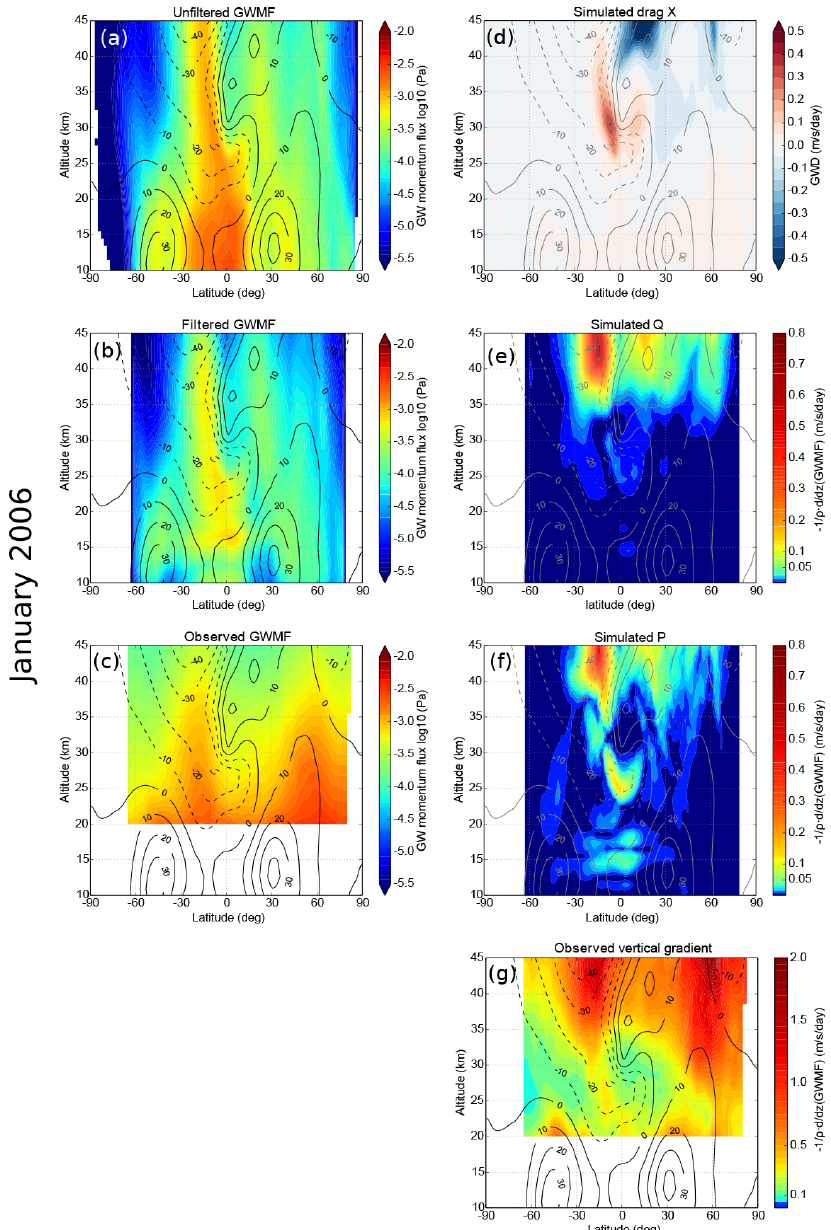
Figure 4. Comparison of simulated GWMF and its vertical gradients with observations from HIRDLS for January 2006. Panel (a) shows simulated unfiltered absolute GWMF. Panel (b) shows simulated filtered absolute GWMF. Panel (c) shows absolute GWMF observed by HIRDLS. Panel (d) shows simulated zonal GW drag. Panel (e) shows simulated vertical gradient Q . Panel (f) shows simulated vertical gradient P . Panel (g) shows observed vertical gradient of absolute GWMF from HIRDLS. Simulations were performed using MERRA data. For details see